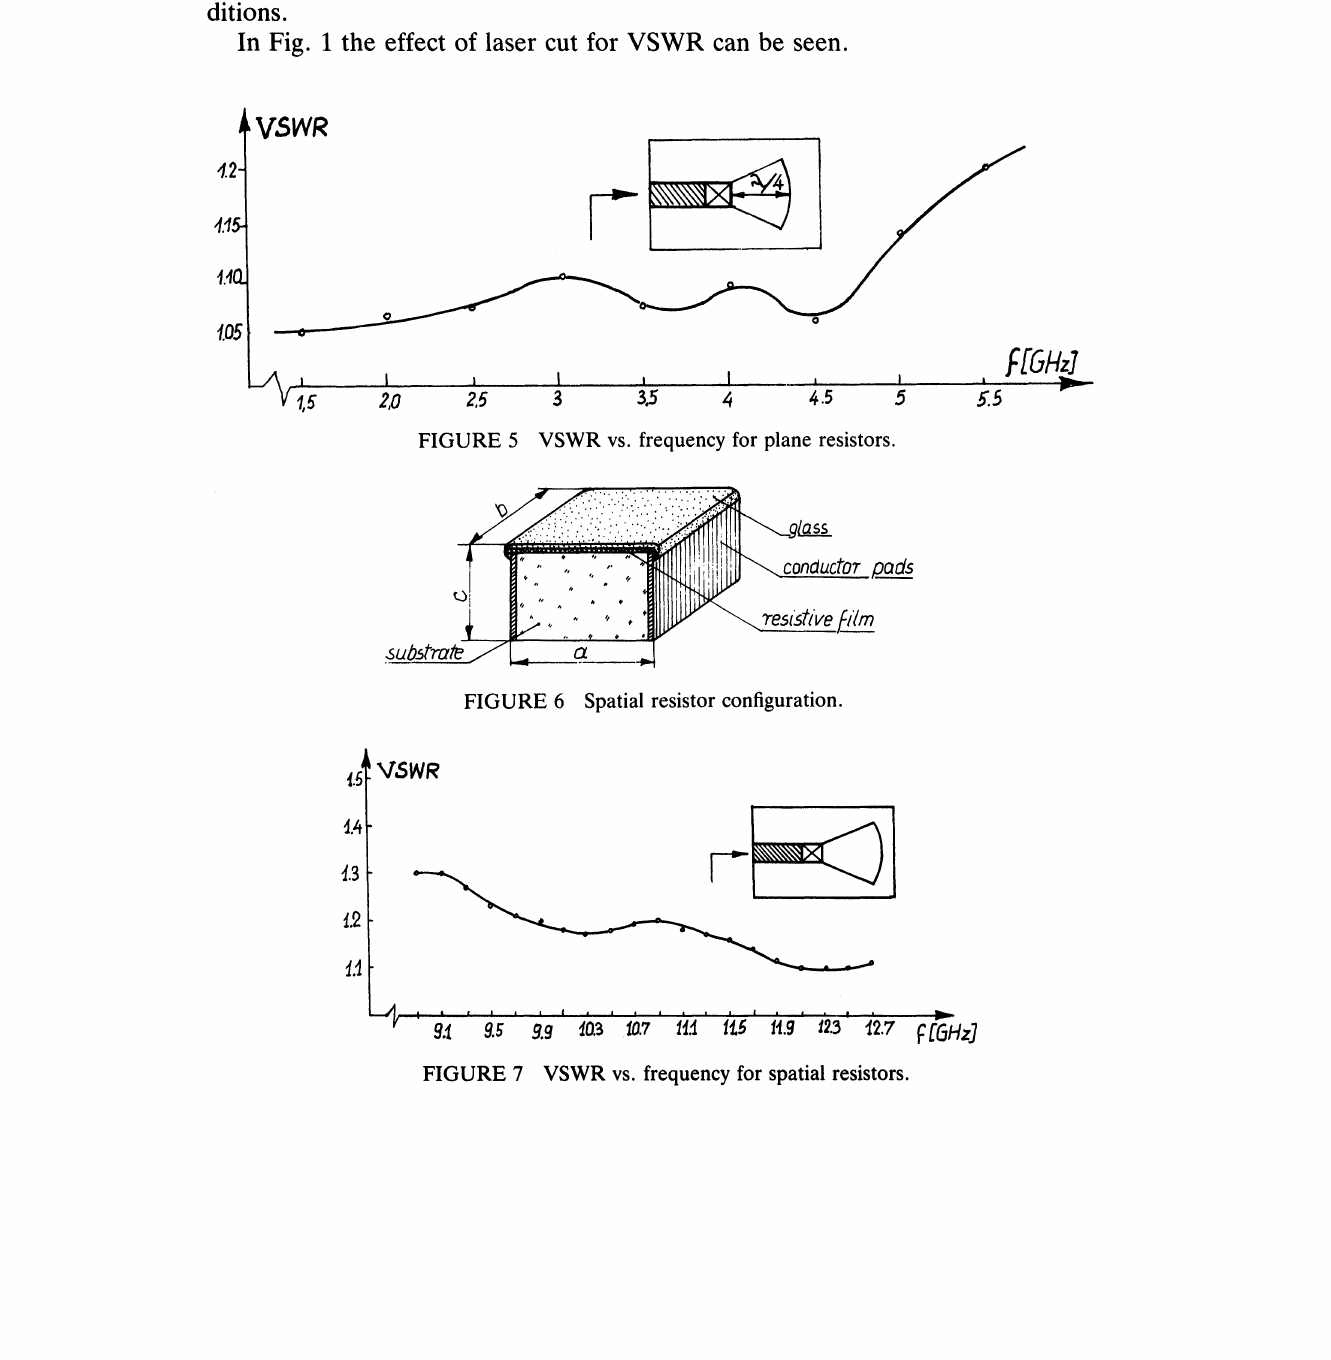
FIGURE 7 VSWR vs. frequency for spatial